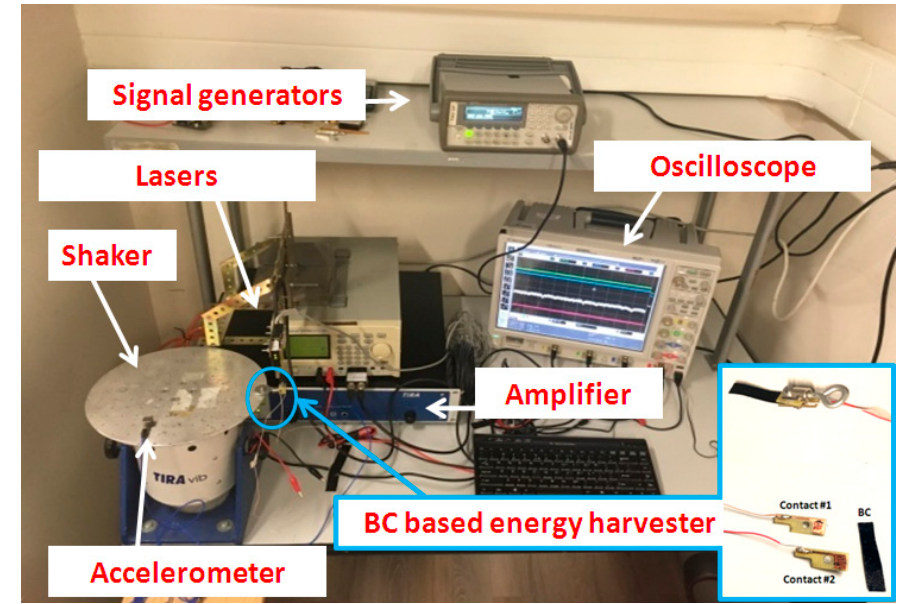
Figure5. Figure 5. Experimental setup used for studying and characterizing the BC-based vibration energy harvester.